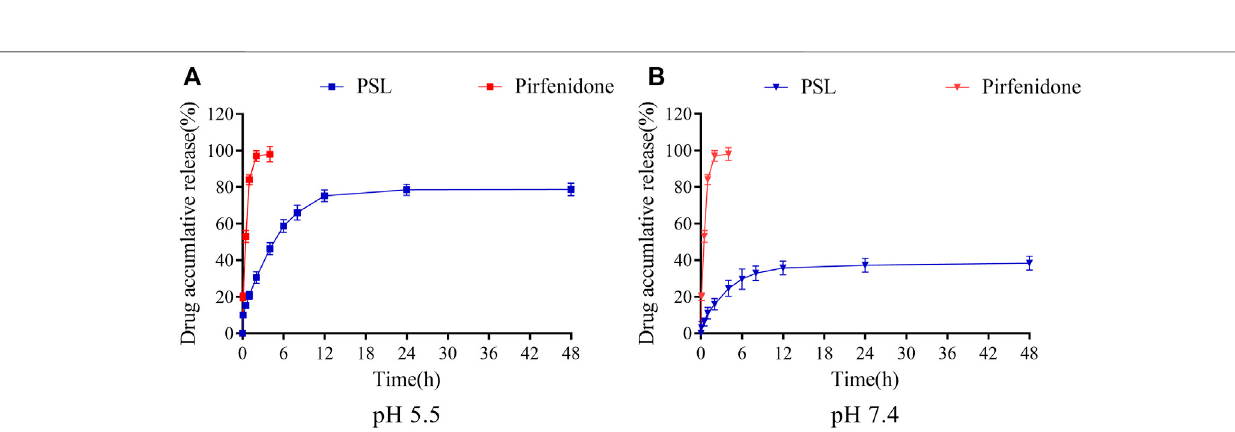
Frontiers in Pharmacology |